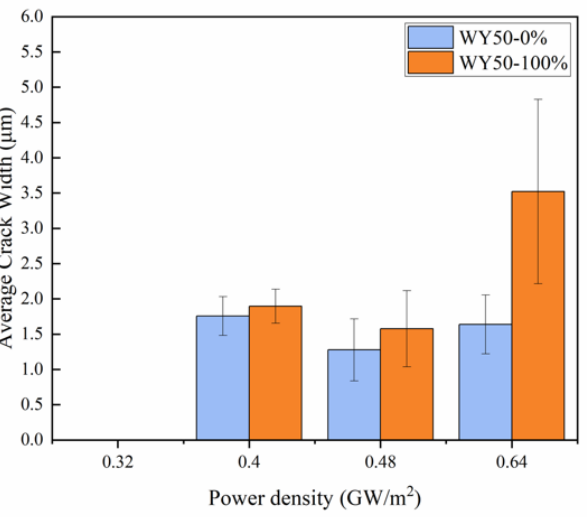
Figure 13. The average crack width variation of WY50 sample with different power densities.